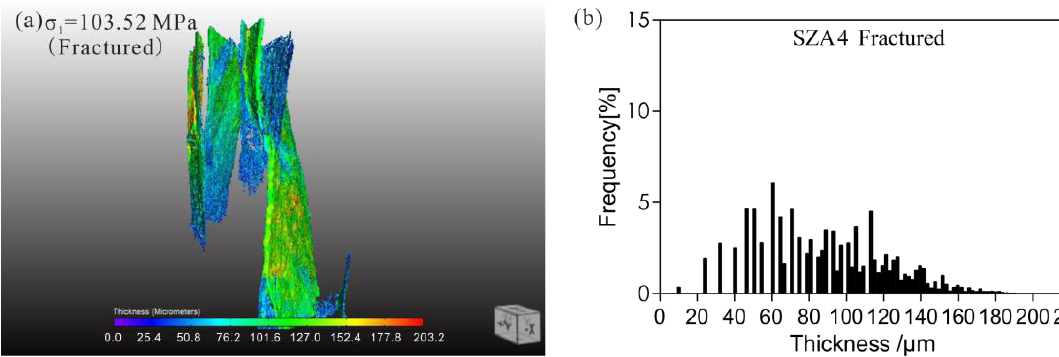
Figure 9. The fracture image and thickness of SZA4. ( a ) 3-D image of fracture (after σ 1 = 103.52 MPa); ( b ) thickness distribution pattern.